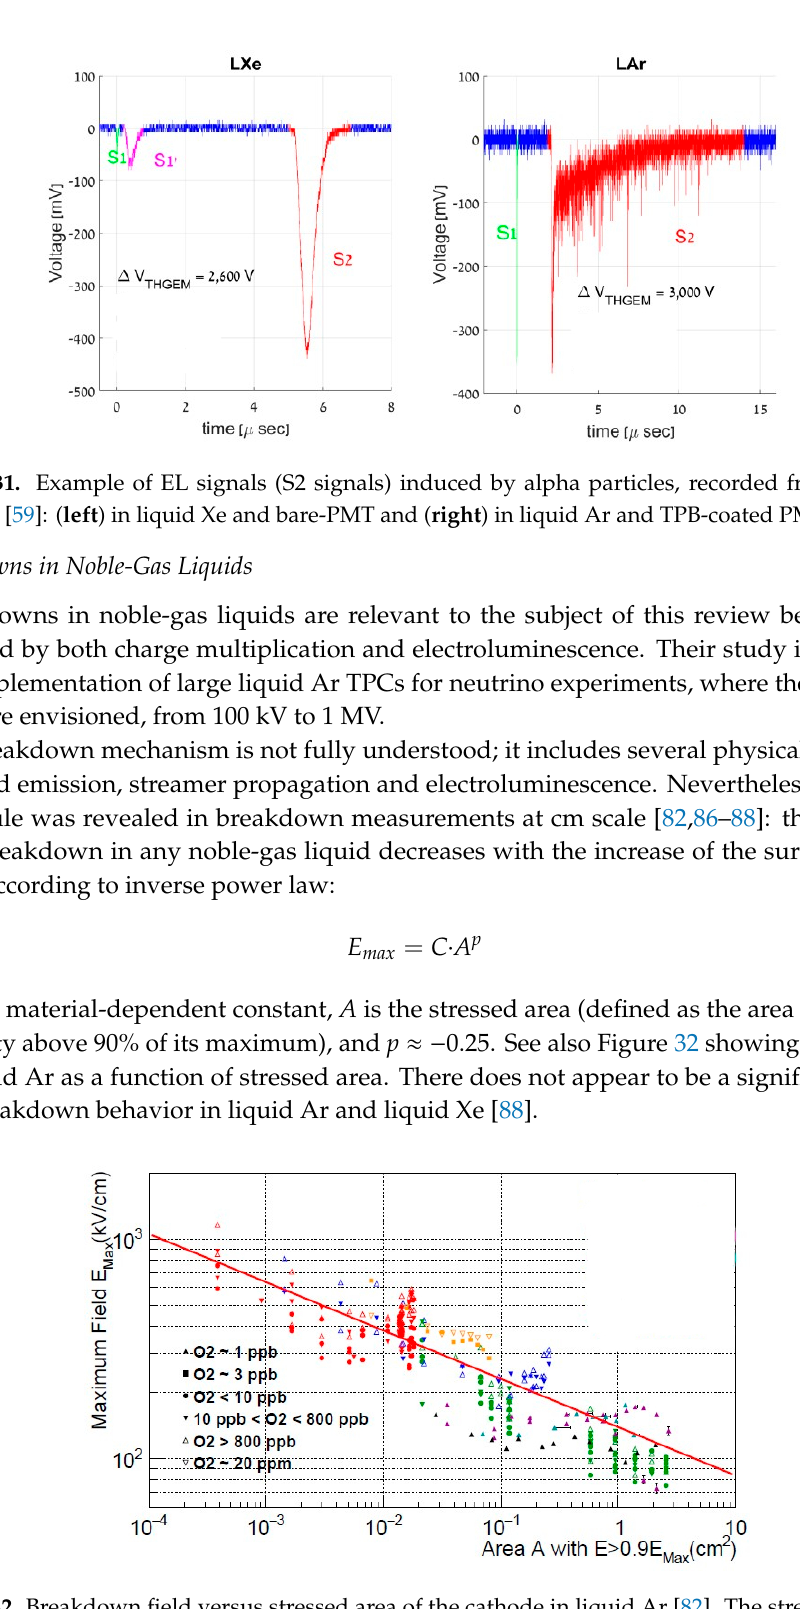
Figure 32. Breakdown field versus stressed area of the cathode in liquid Ar [82]. The stressed area is defined as the area with electric field greater than 90% of the maximum electric field in the gap. The fit line represents the dependence 𝐸 (cid:3040)(cid:3028)(cid:3051) = 𝐶 ∙ 𝐴 (cid:3043) with 𝐶 = 139 and 𝑝 = −0.22 .